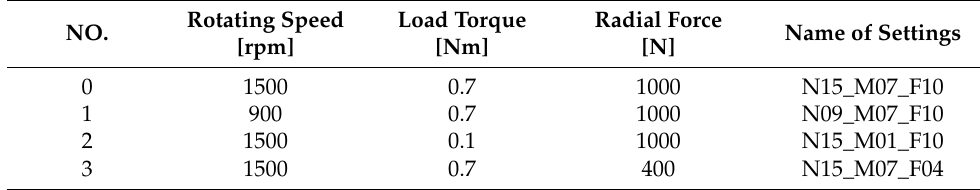
Figure 4. ( a ) Test rig in Case 1; ( b ) outer ring fault; and ( c ) inner ring fault. Table 2. Operating parameters of test rig in Case